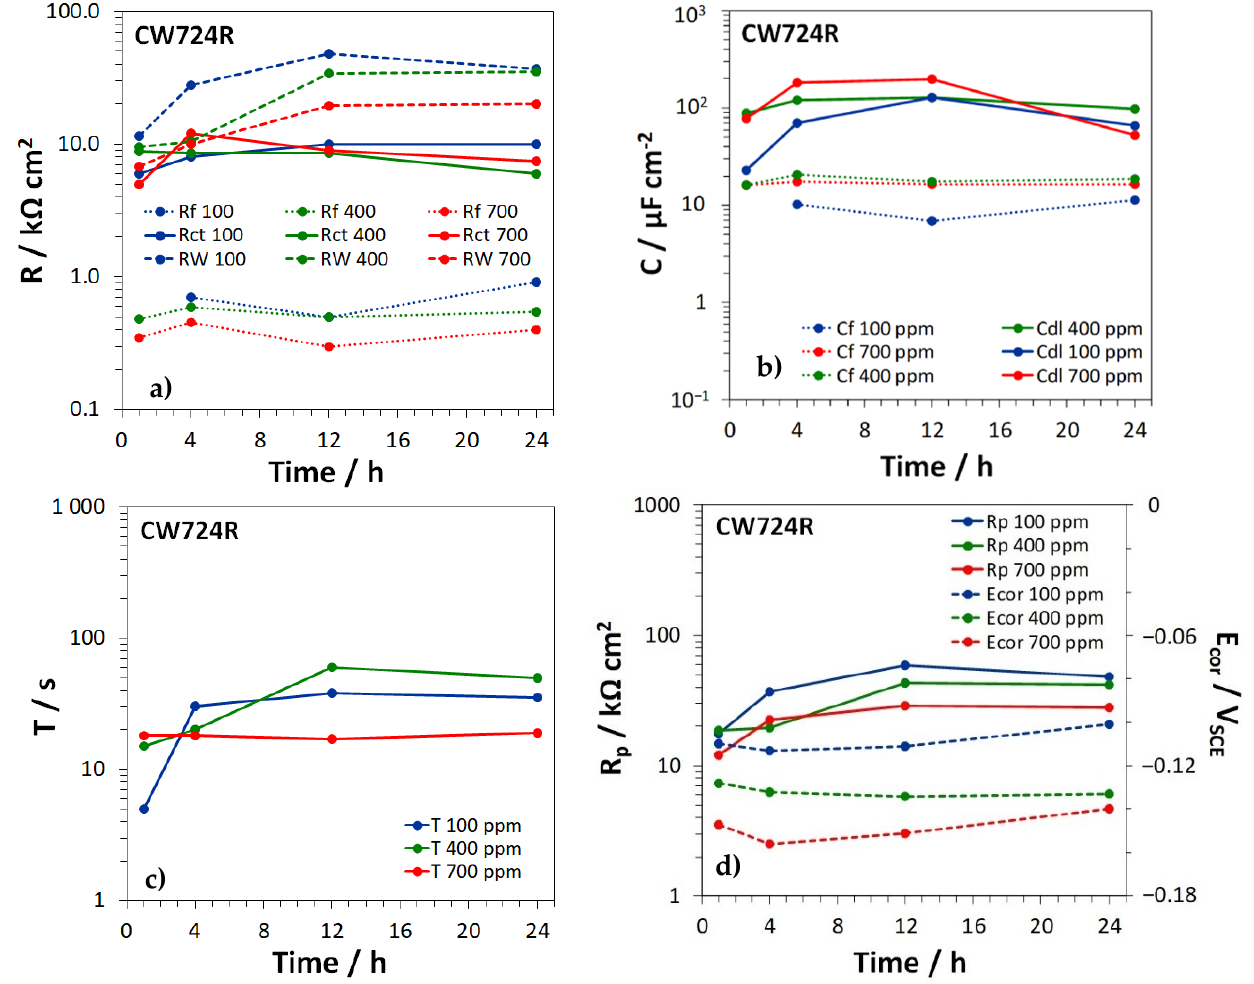
Figure 10. Time dependence of ( a ) the film, charge transfer, and diffusion resistances ( R f , R ct , and R W ); ( b ) the film and double layer capacitances ( C f and C dl ); ( c ) the T parameter of the GFLW element; and ( d ) the polarization resistance ( R p ) and corrosion potential values (E cor ), measured on CW724R during the immersion in SDW with three different chloride concentrations.